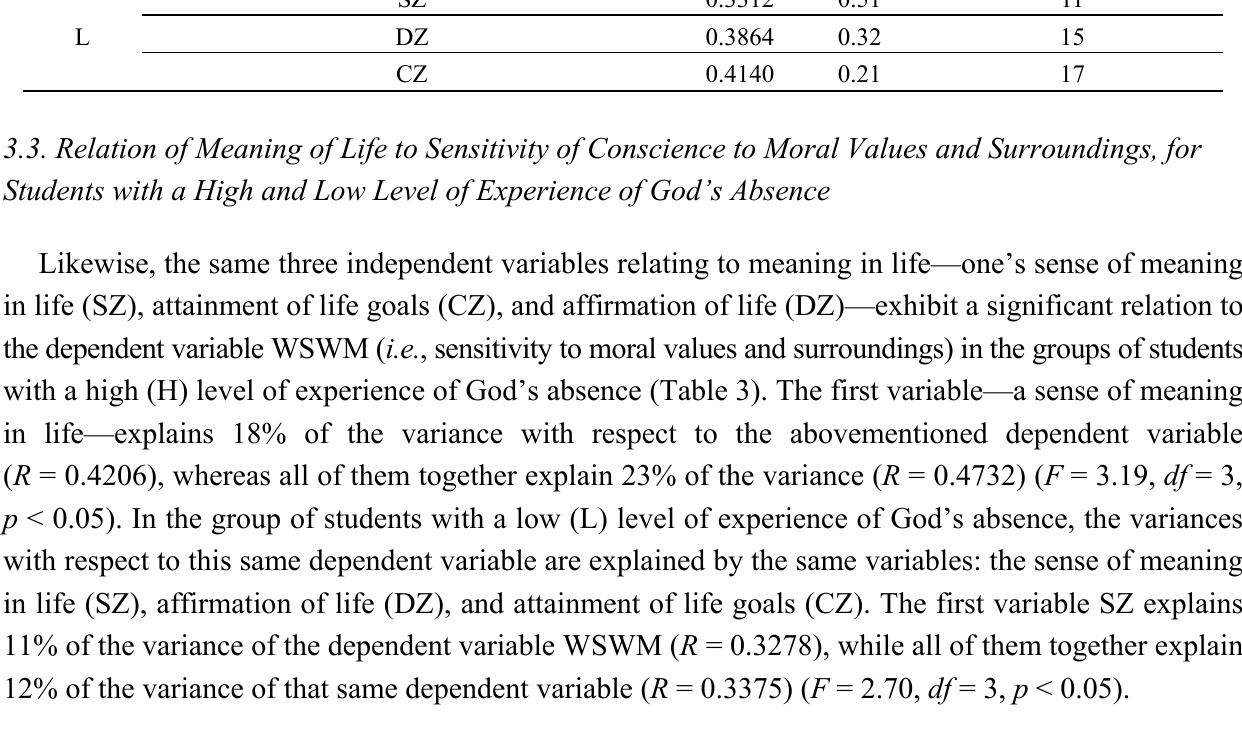
Table 3. Independent variables relating to meaning in life: a sense of meaning in life (SZ), attainment of goals (CZ), and affirmation of life (DZ) explaining variance with respect to sensitivity of conscience to moral values and surroundings (WSWM) in groups of students with a high (H) or low (L) level of experience of God’s absence. Results of multiple stepwise regression